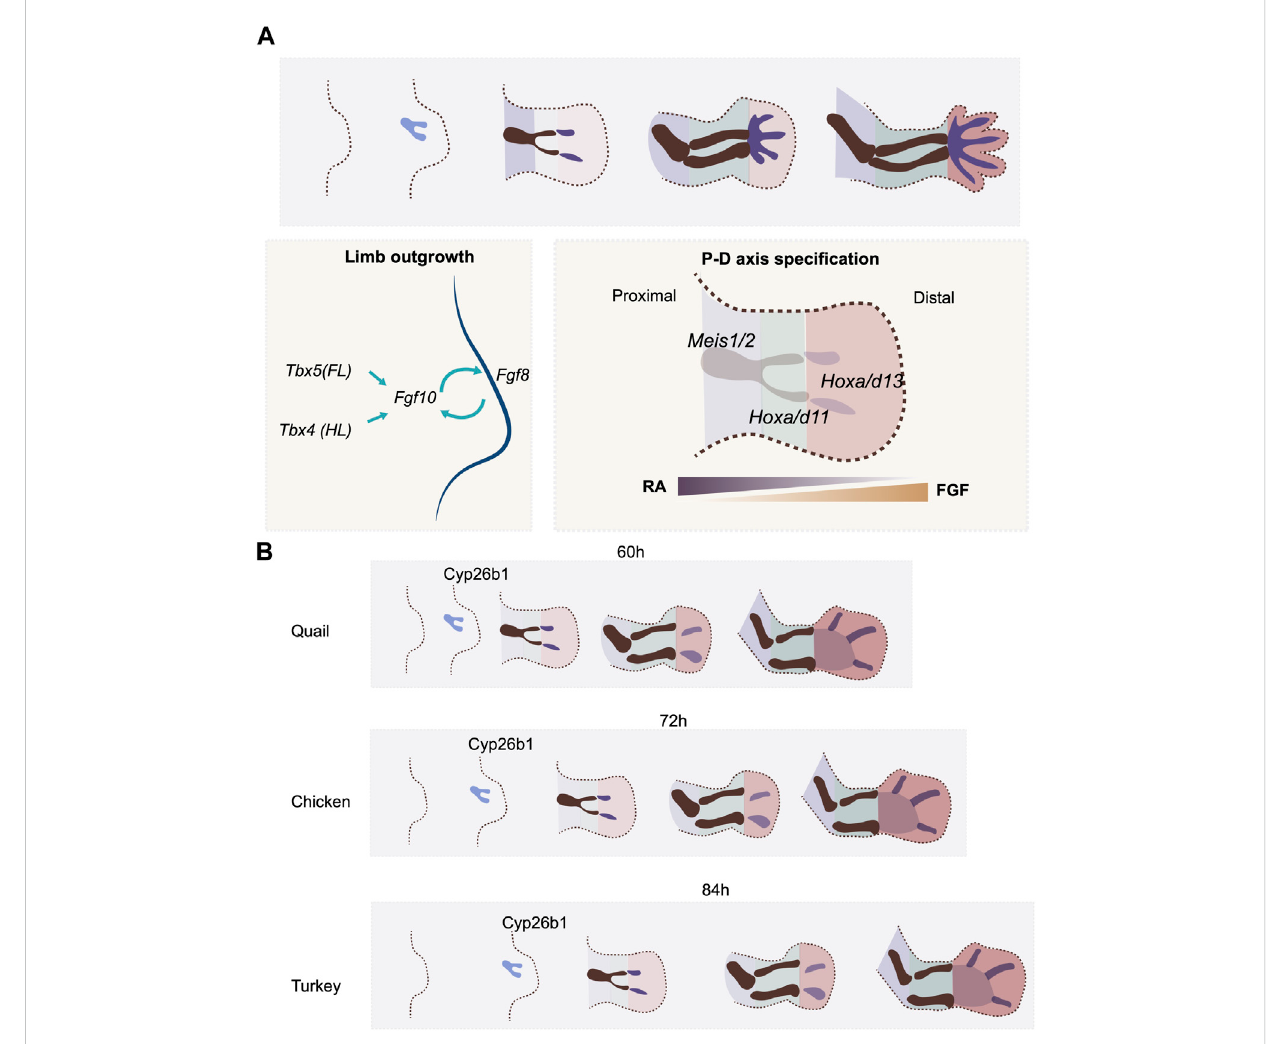
FIGURE 2 P-D axis speci fi cation and temporal alterations. (A) P-D axis is speci fi ed by reciprocal gradients between RA and FGF signaling. Three segments are speci fi ed along the P-D axis, marked by the expression of transcription factors, Meis, Hox9 and Hox11. (B) the timing of expression of a RA degradation enzyme. Cyp26b1, regulates the timing of P-D axis speci fi cation rate in quail, chicken and turkey embryos.